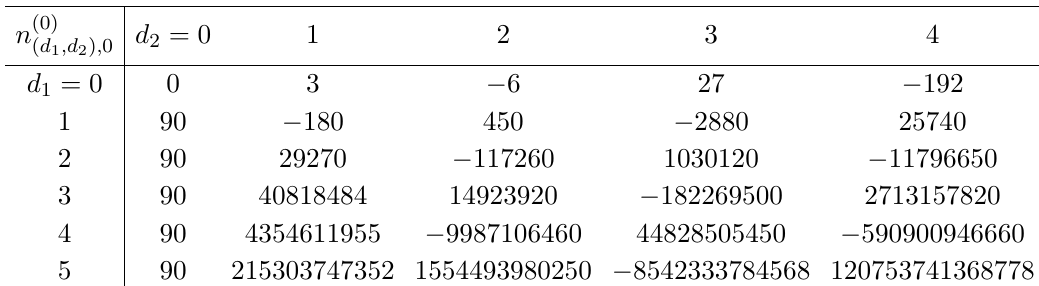
with Z charge 0 . 5 0